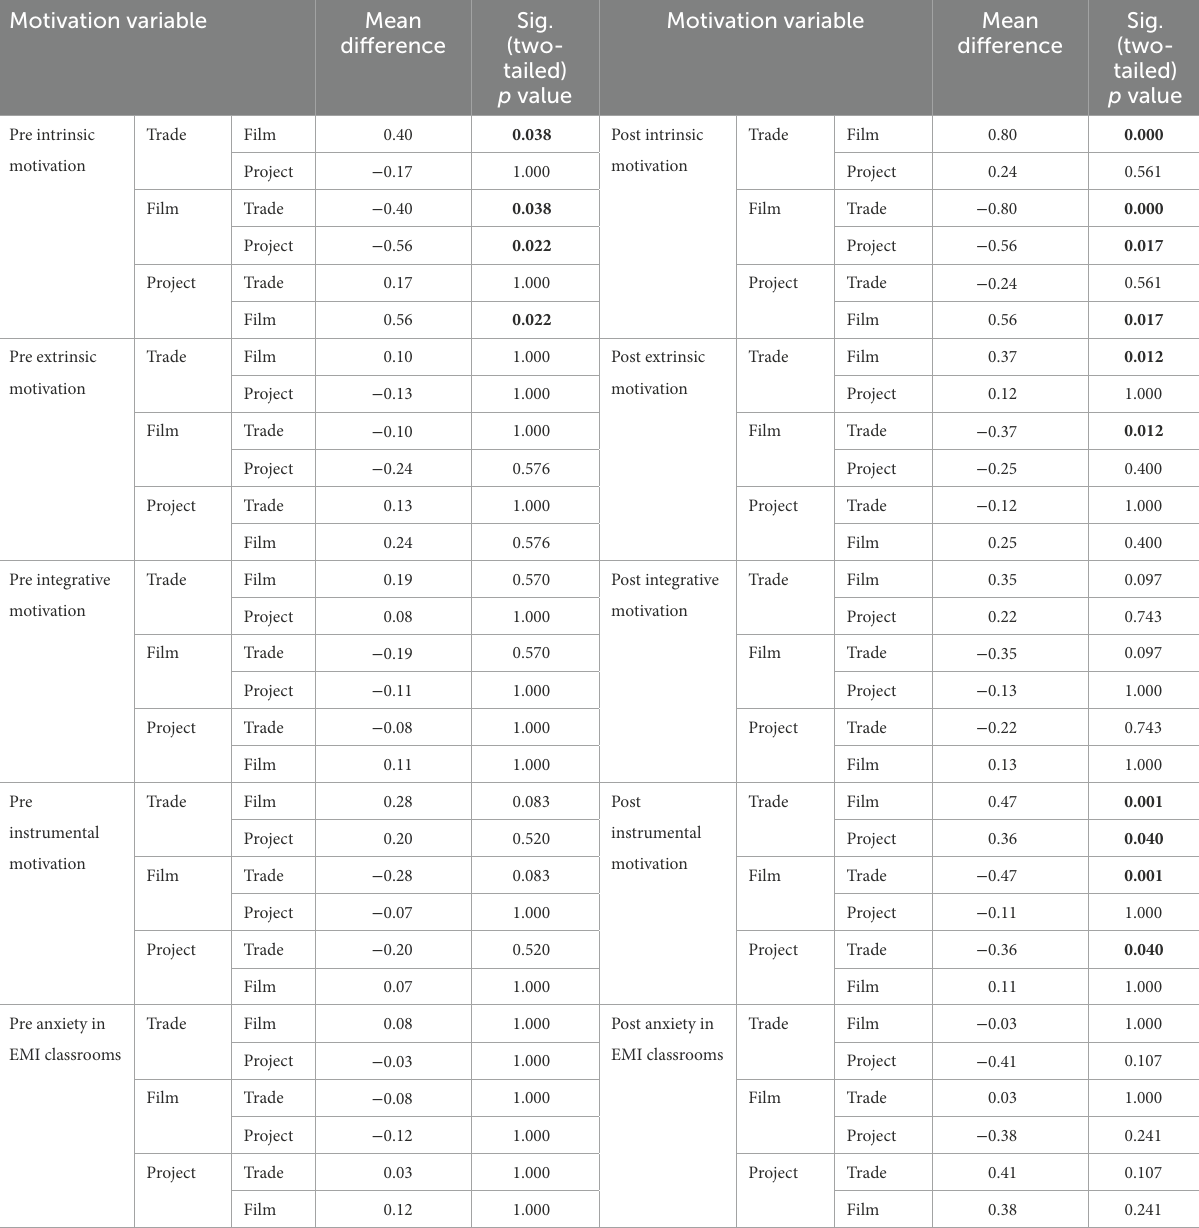
TABLE 4 Pre-post student questionnaires (motivation variable differences among the three disciplines). Motivation